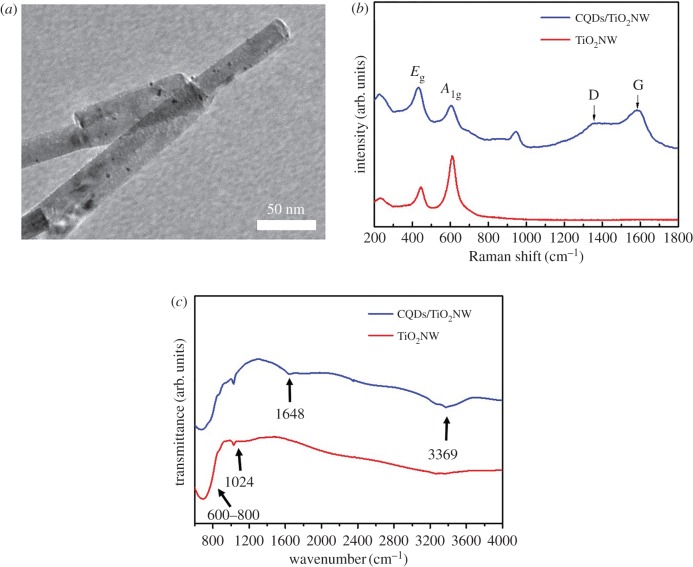
(a) HRTEM of CQD/TiO2 NWs; (b) Raman spectra; and (c) FTIR spectra of TiO2 NWs and CQDs/TiO2 NWs.